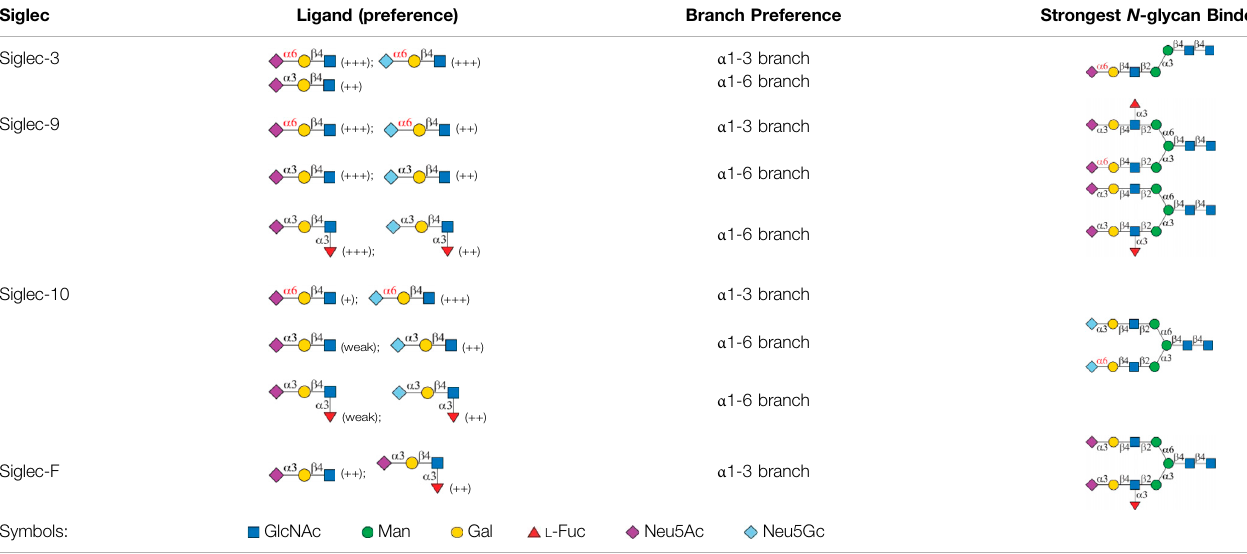
TABLE 1 | Binding speci fi city of Siglecs toward N -glycans observed in this study. Recombinant Siglec-Fc chimera proteins were used in this study.